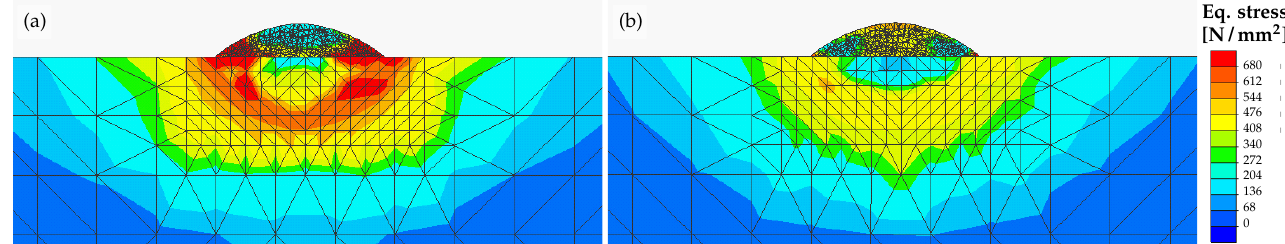
Figure 10. Sectional view transversely to the welding direction with equivalent stresses: ( a ) Deposition welding without preheating. ( b ) Deposition welding with simultaneous inductive